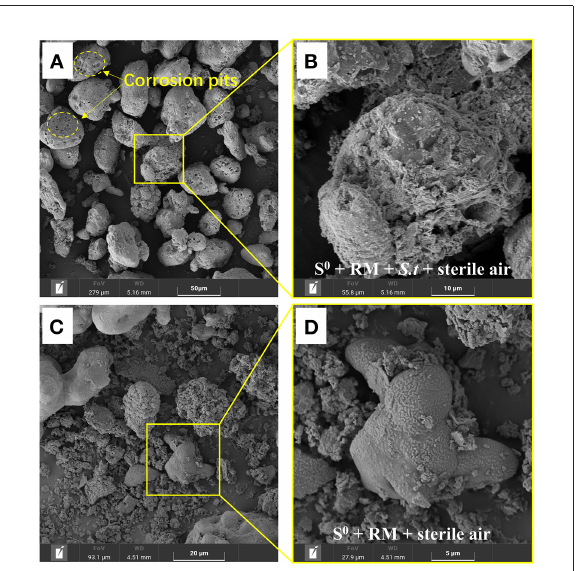
FIGURE8 SEM images of the solid residues after leaching of metals from RM. (A,B) Biotic assays with aeration, (C,D) abiotic assays with aeration, where (B,D) represent enlarged areas marked in (A,C) , respectively. Bioleaching was conducted for 27 days in a 5-L STR with the S 0 /RM mass ratio of 2:1 and aeration rate of 1 L/min.